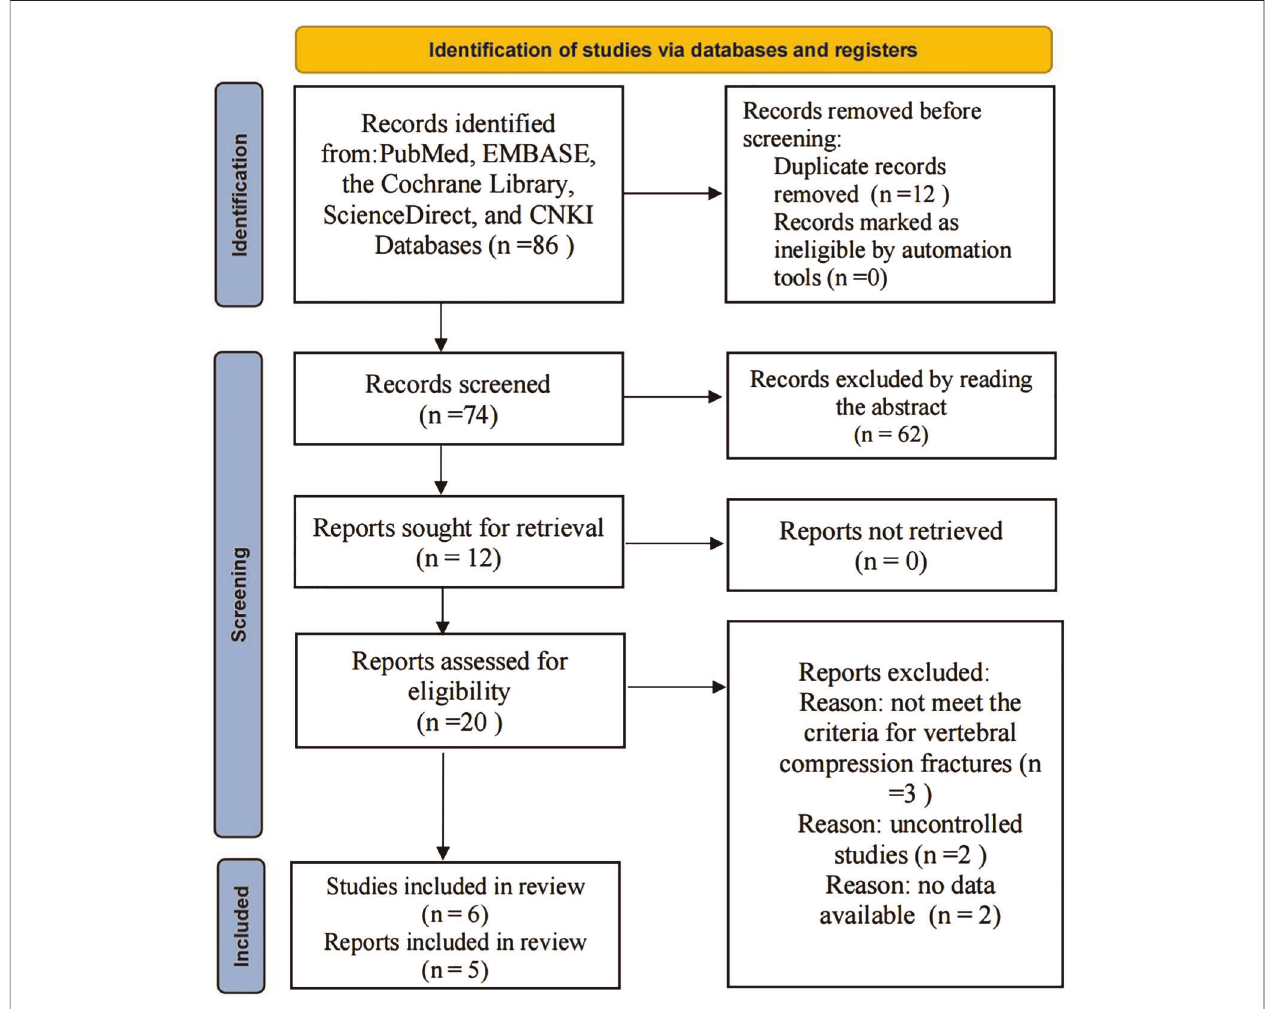
FIGURE 1 | PRISMA fl